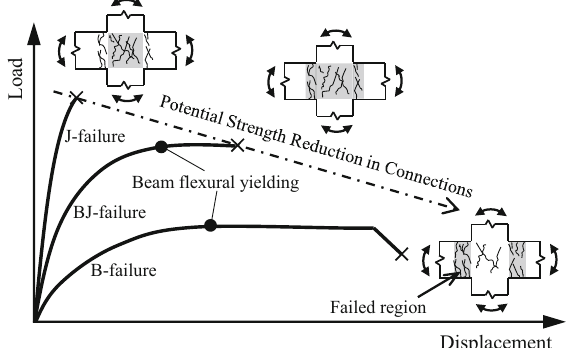
Fig. 1 Types of failure modes of the beam–column joints (Lee et al.